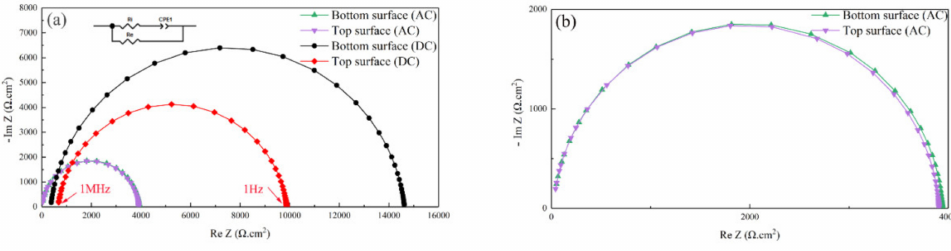
Figure 6. ( a ) Nyquist Plot recorded at 30 ◦ C for LiFePO 4 samples consolidated using DC and AC and ( b ) its enlarged